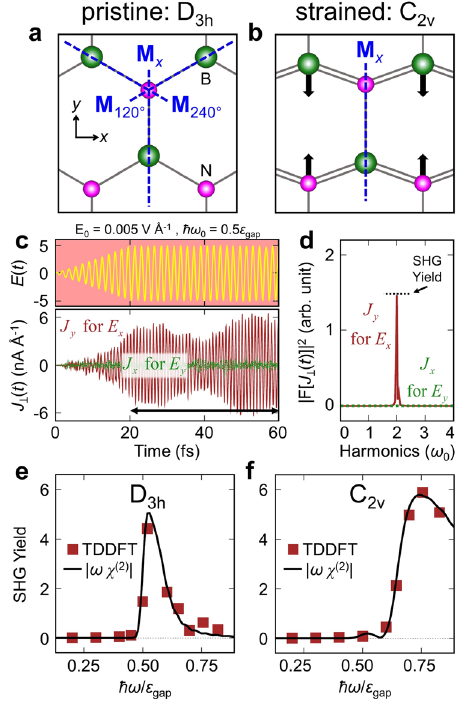
Fig. 2 The second harmonic Hall current spectra in h-BN. a and b are the top views of the three-fold D 3h symmetric pristine and the two-fold C 2v symmetric uniaxial strained h-BN monolayers, respectively. The blue dashed lines represent the mirror planes: M x is perpendicular to the x -axis; M 120° and M 240° are obtained by rotating the M x plane clockwise 120° and 240° around the z -axis, respectively. The upper plane of c is the real-time pro fi le of the continuous light fi eld applied to the pristine h-BN. The solid brown and dotted green oscillating lines in the lower plane are the transverse current density responses obtained by the real-time time- dependent density functional theory (TDDFT) calculations with the polarization of the applied fi eld in the x -axis and y -axis, respectively. d The Fourier transformation of the current densities given in c for the time interval of 20 fs ≤ t ≤ 60 fs (the black horizontal arrowed line). The horizontal dashed line depicts the second harmonic generation (SHG) yield. e The SHG yields obtained from TDDFT (brown squares) and the theoretical SHG susceptibility spectra (black lines) for the pristine h-BN (with D 3h symmetry) with respect to various driving frequencies. f The same plots as e for a strained h-BN (with C 2v symmetry). The light frequency in the horizontal axis is normalized with the bandgap of each structure (4.75 eV for D 3h and 3.61 eV for C 2v